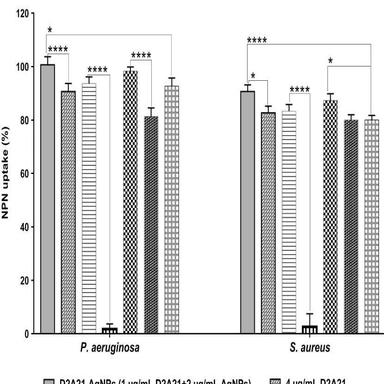
Determination of intracellular K+ leakage from P. aeruginosa and S. aureus after treatment with P-AgNPs, native peptides, and chemically synthesized AgNPs. Positive and Negative controls were maintained as bacterial cell suspensions with 70% ethanol and no drug treatment, respectively. The statistical significance was observed between P-AgNPs and native peptides; P-AgNPs and chemically synthesized AgNPs.